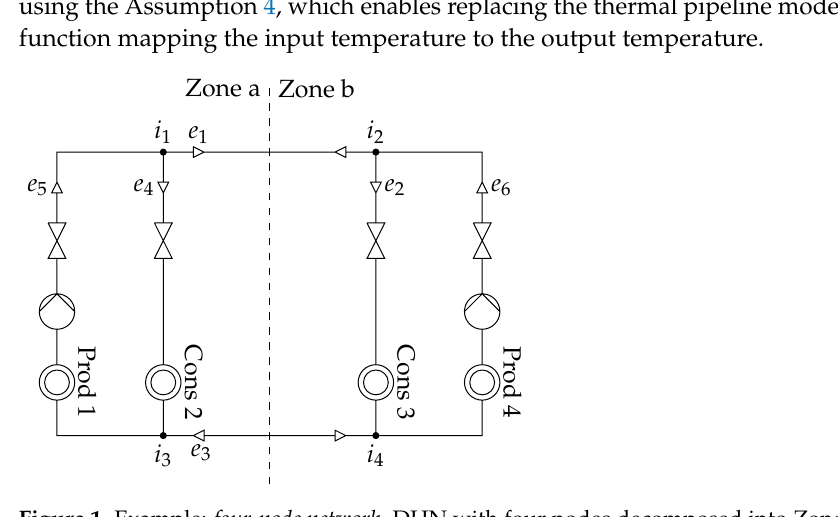
Figure 1. Example: four-node network. DHN with four nodes decomposed into Zones a and